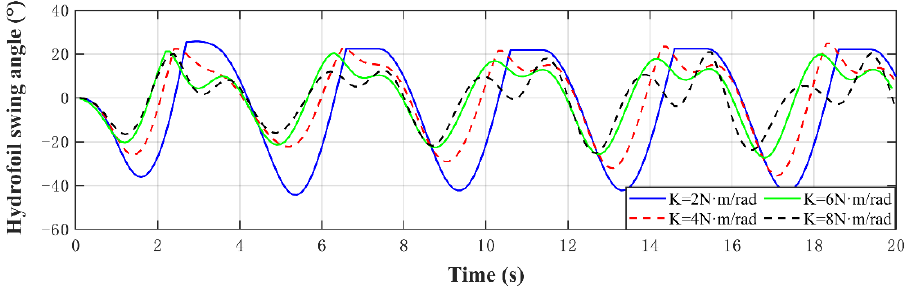
Figure 15. The swing angles of the hydrofoil for the conventional submerged glider under the different K.